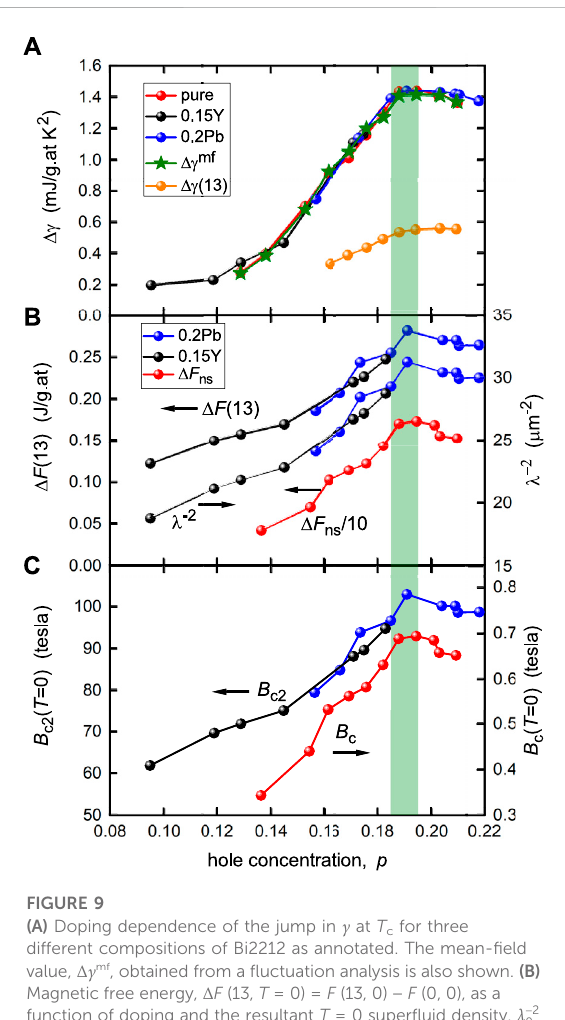
FIGURE 9 (A) Doping dependence of the jump in γ at T c for three different compositions of Bi2212 as annotated. The mean- fi eld value, Δ γ mf , obtained from a fl uctuation analysis is also shown. (B) Magnetic free energy, Δ F (13, T = 0) = F (13, 0) − F (0, 0), as a function of doping and the resultant T = 0 super fl uid density, λ − 2 0 obtained using Eq. 6. (C) Doping dependence of derived critical fi elds, B fi eld, B c2 , and the thermodynamic critical c